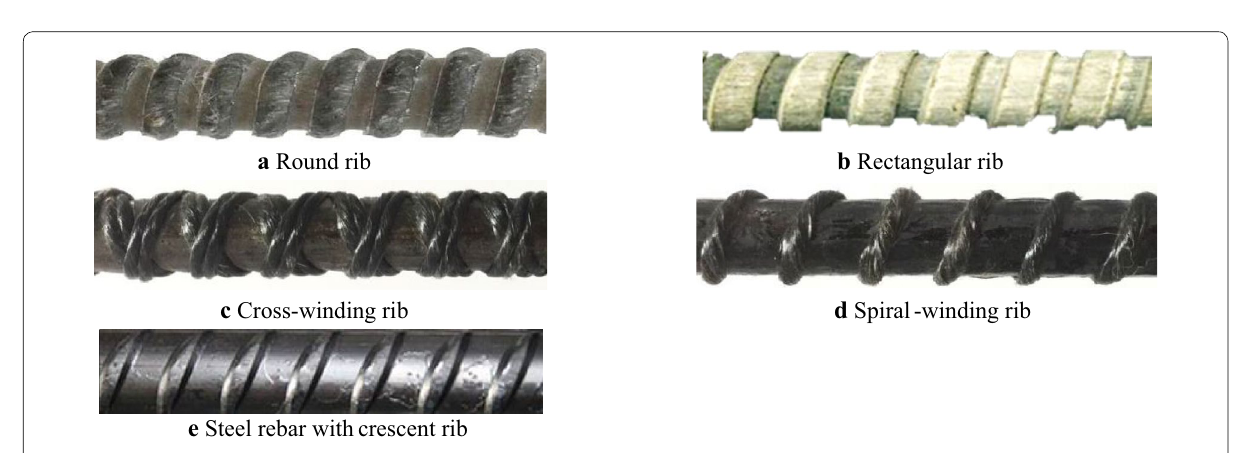
Fig. 2 Surface shape of